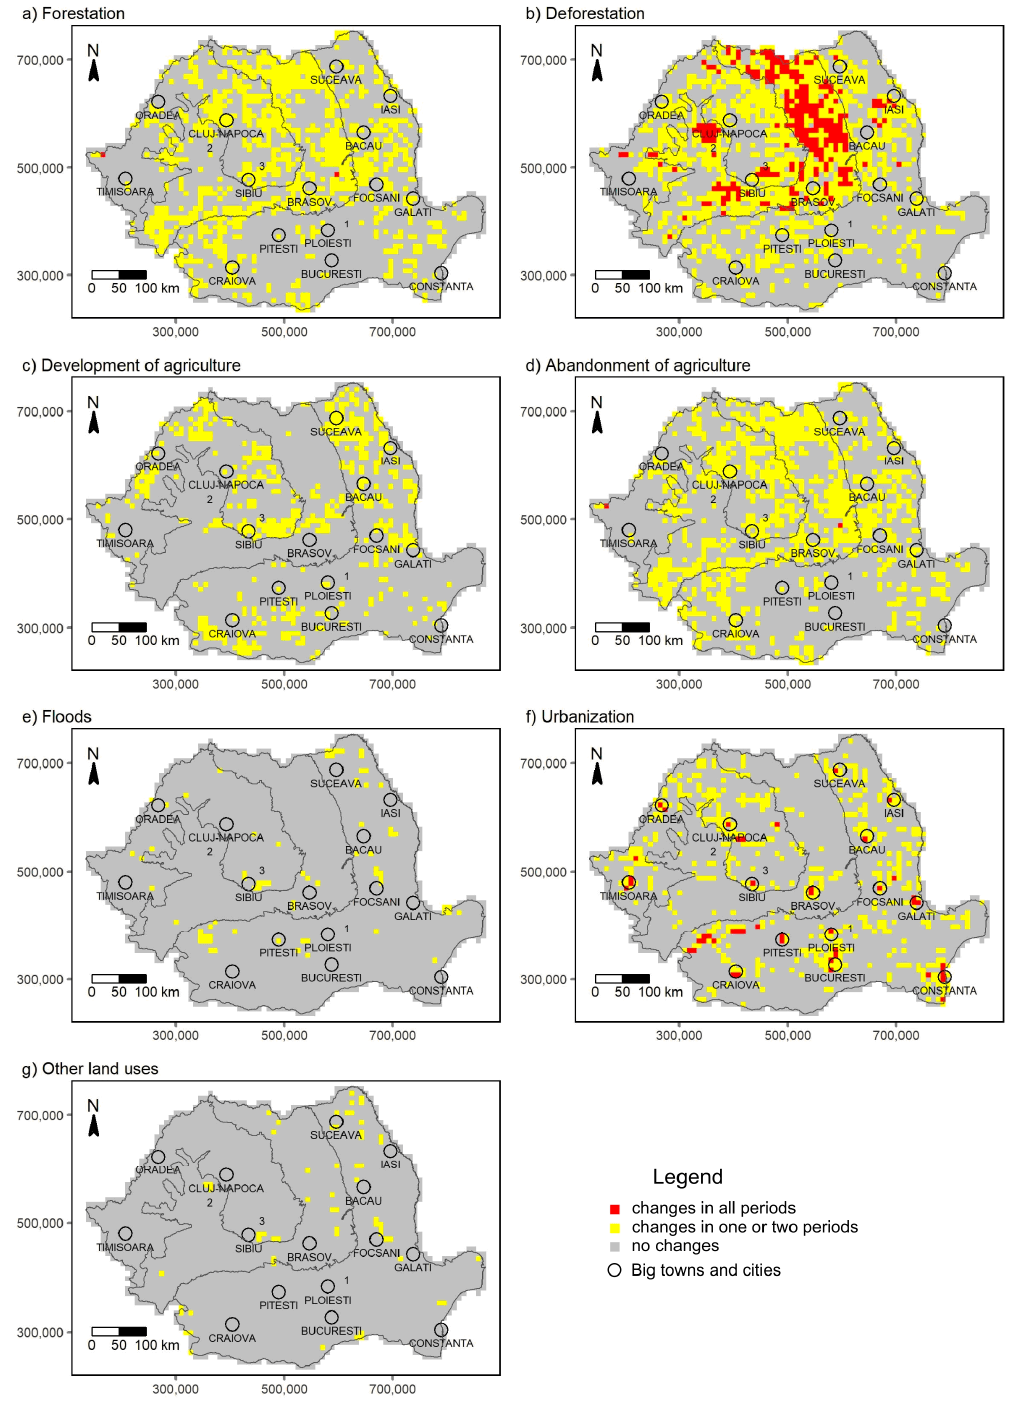
Figure 3. Land use changes by grid cells. The image pinpoints areas where LCUC were frequent, occurring in at least one period, and indicating the occurrence of forestation ( a ), deforestation ( b ), development of agriculture ( c ), abandonment of agriculture ( d ), floods ( e ), urbanization ( f ), or other changes ( g ).